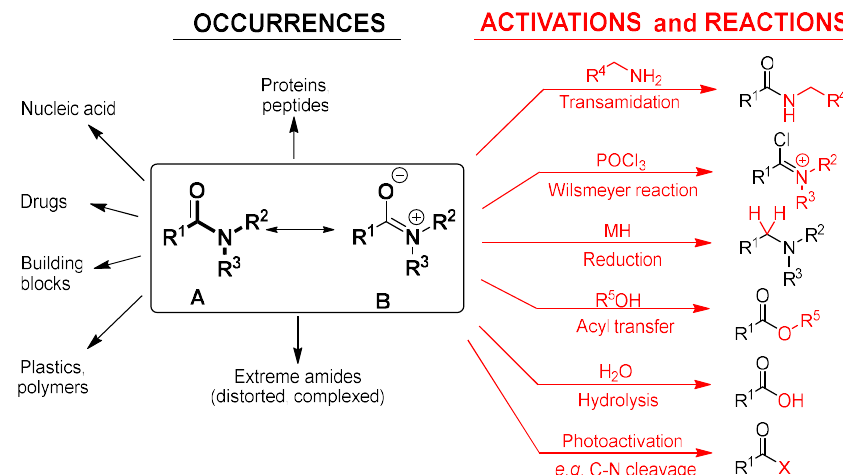
Figure 1. Contributing resonance structures of an amide bond (in the box). The occurrences ( left ) of the amide functionality and their typical reactions ( right ).